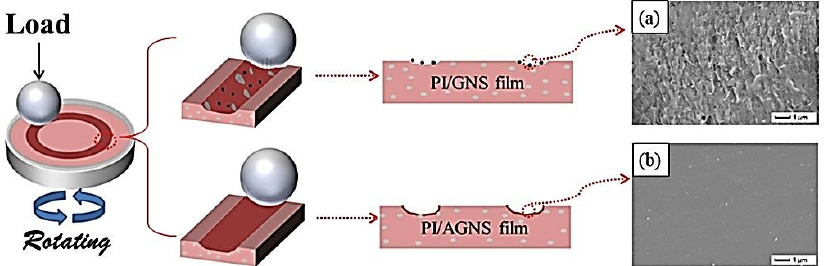
Figure 8. A model of the friction mechanism for the ‘PI + GNS’ and ‘PI + AGNS’ films. The inset is the SEM images of worn surface of ( a ) PI/GNS-1wt% nanocomposite and ( b ) PI/AGNS-1wt% nanocomposite. Figure is reproduced with permission from reference [54].